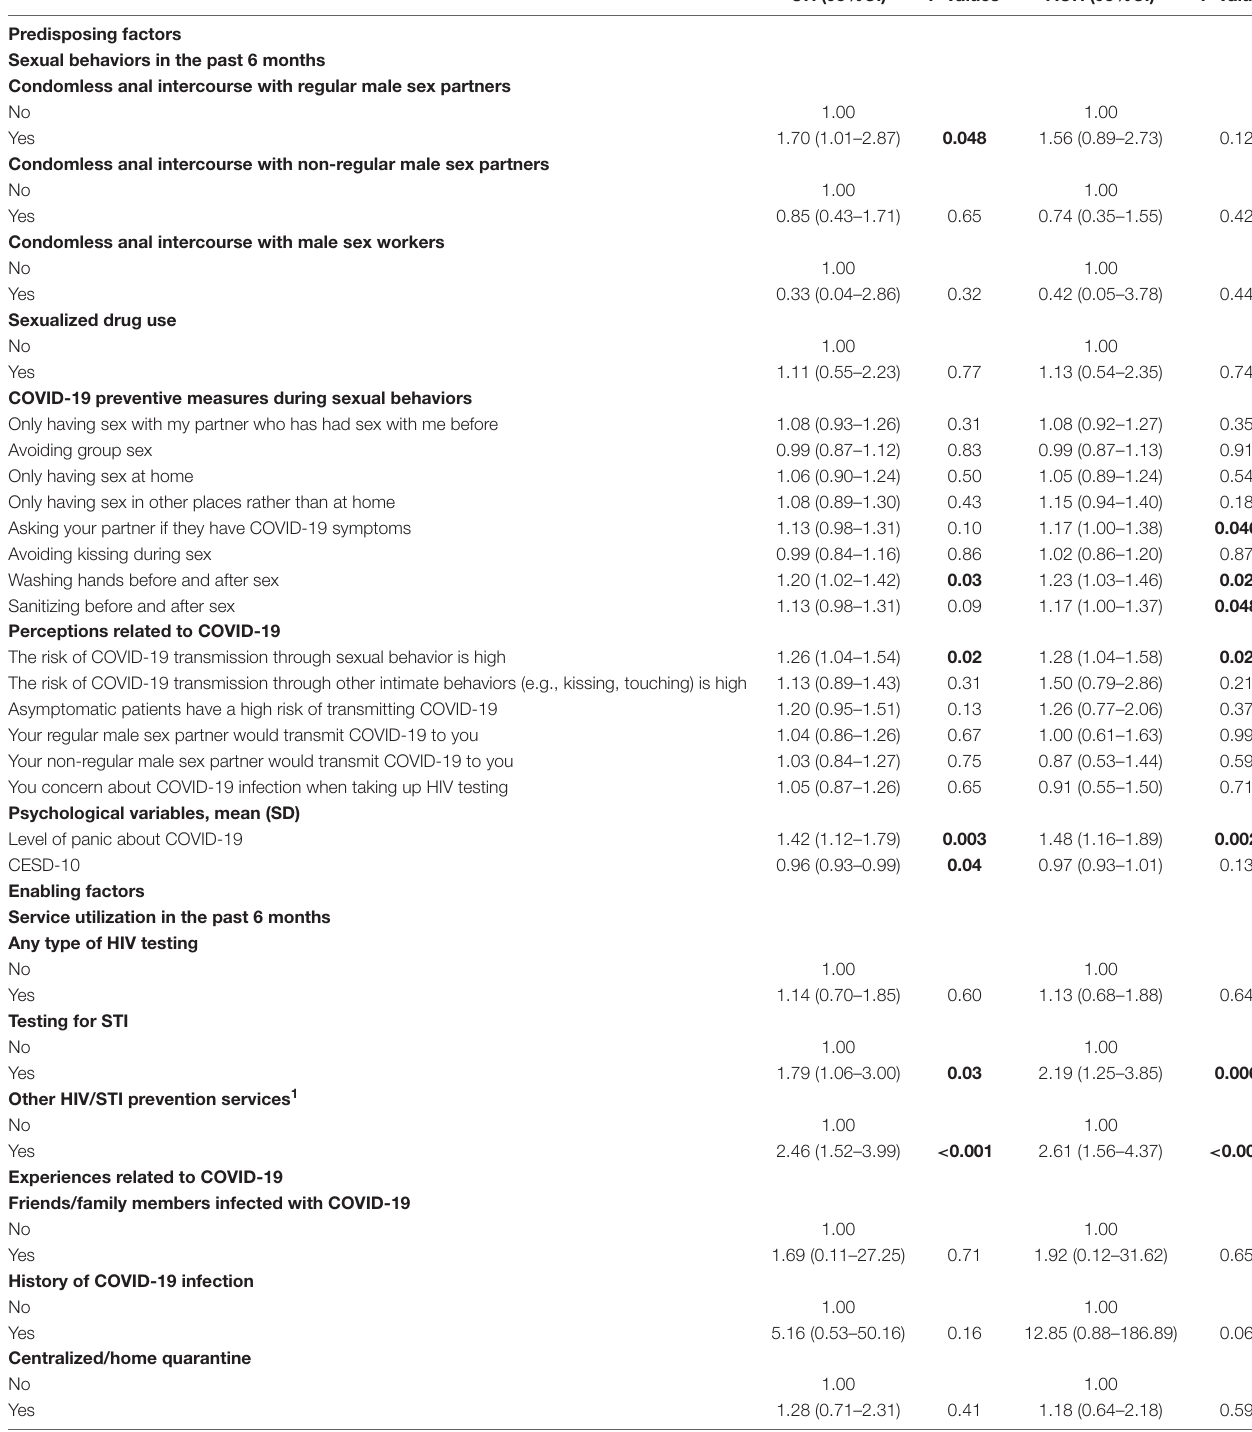
TABLE 3 | Factors associated with uptake of COVID-19 vaccination (at least one dose) during the follow-up period (among participants who completed both surveys, n =